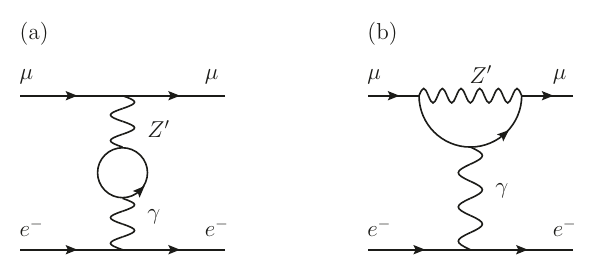
(cid:22) (cid:0) L (cid:28)